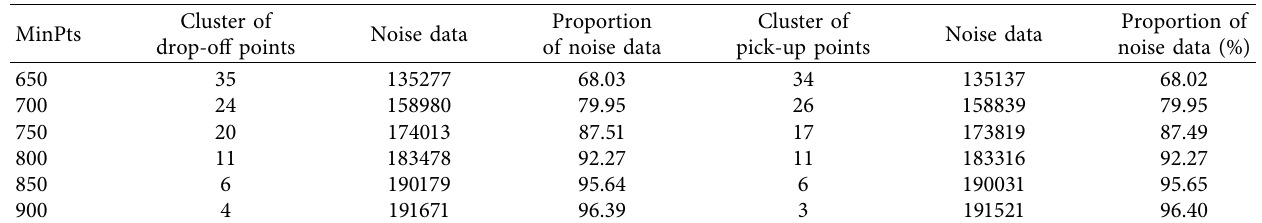
Figure 2: K -distance graph of GPS data in different time periods: (a) 3min, (b) 5min, (c) 8min, (d) 10min, (e) 11min, and (f) 12min. Table 1: Clustering results of the pick-up (drop-off)